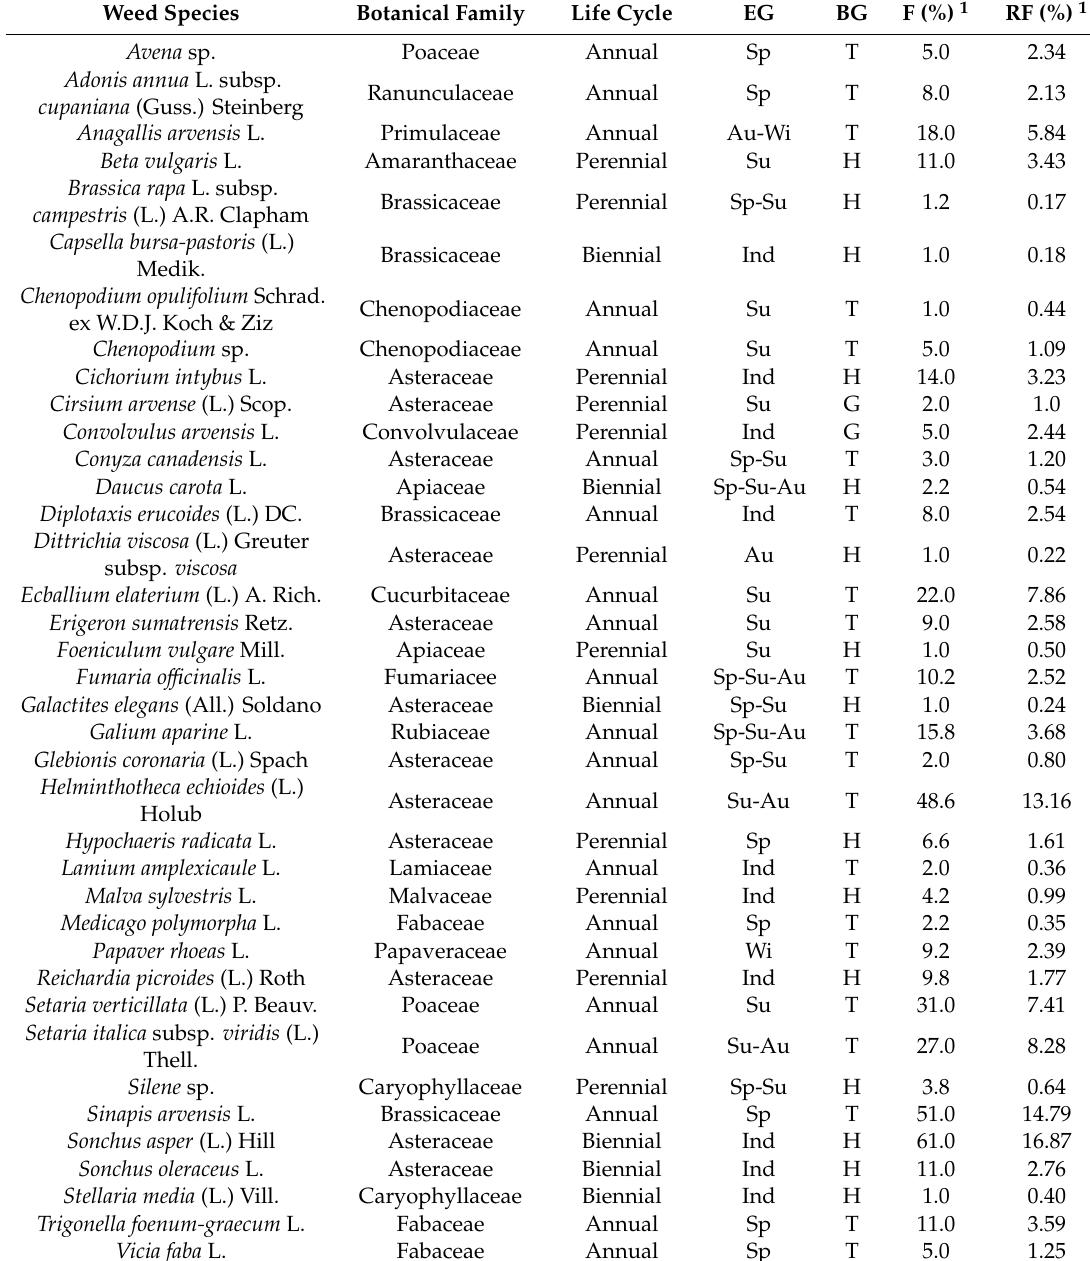
Table 1. Botanical family, life cycle, ecophysiological (EG) and biological groups (BG), frequency (F) and relative frequency (RF) of weed population among 5 cropping systems and 5